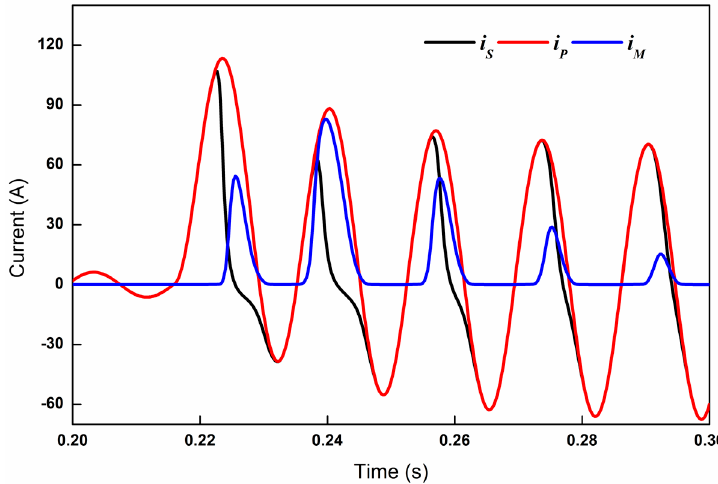
Figure 1. Measured current waveform from CT with unsaturated and saturated waveforms